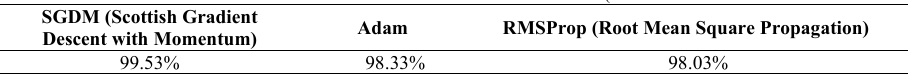
Fig. 9 is the confusion matrix of architecture 5 for MNIST dataset, which shows that this model can achieve the highest accuracy of 99.5% (i.e., round off of 99.53%) for ten-class classification. The diagonal values represent the individual class